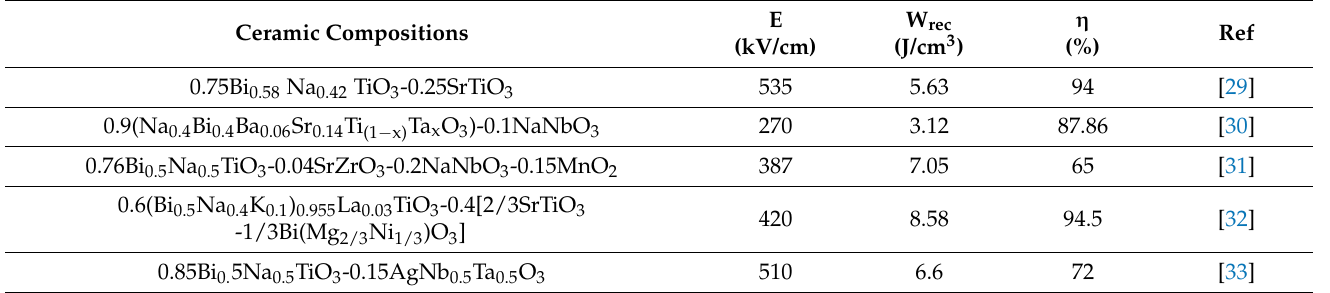
Table 3. ESP of BNT-based ceramics modified by defect